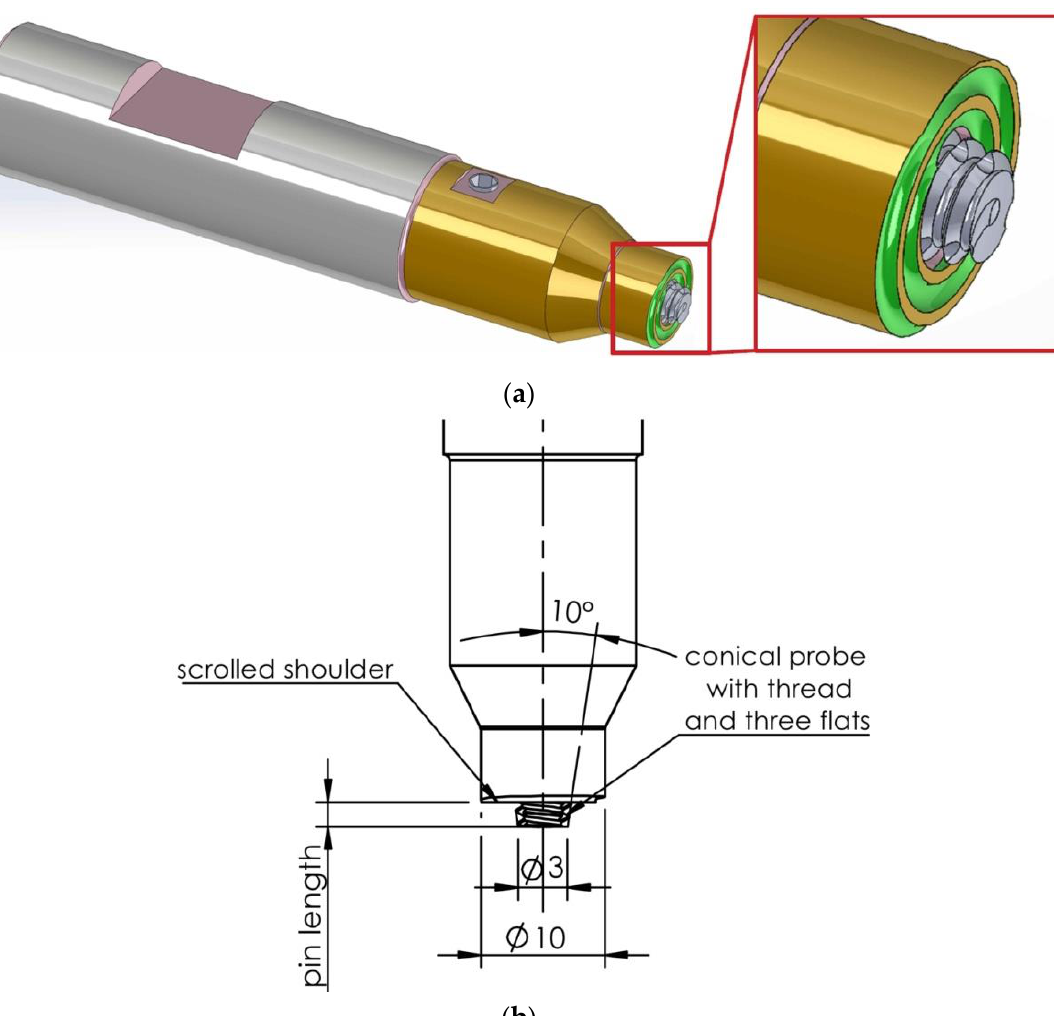
Figure 2. ( a ) View and ( b ) dimensions of the FSW tool (unit: mm). Table 3. The welding parameters used in the DoE matrix assigned to the DoE level ( − 1, 0, +1). Welding Speed f, Tool Rotational DoE Level Pin Length d, mm mm/min Speed n, rpm − 1 1.1 200 800 0 1.5 300 1200 +1 1.9 400